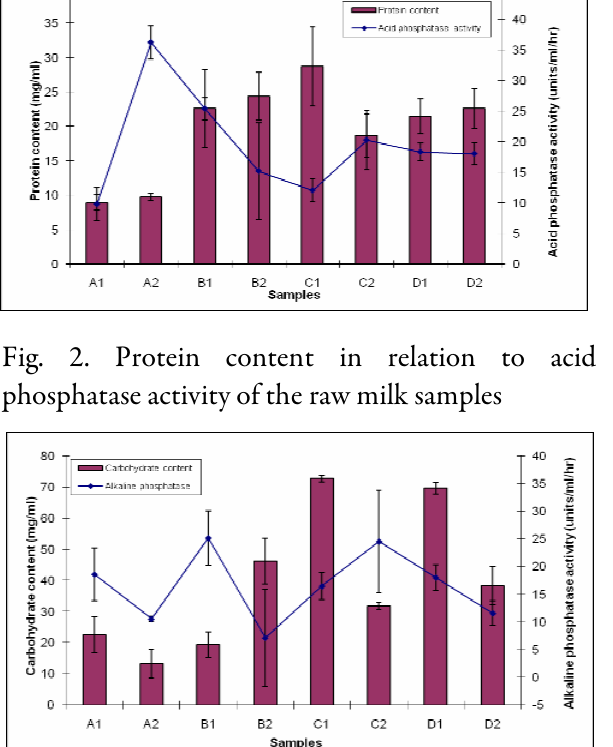
Tab. 1. Enumeration of bacterial population in nutrient agar media